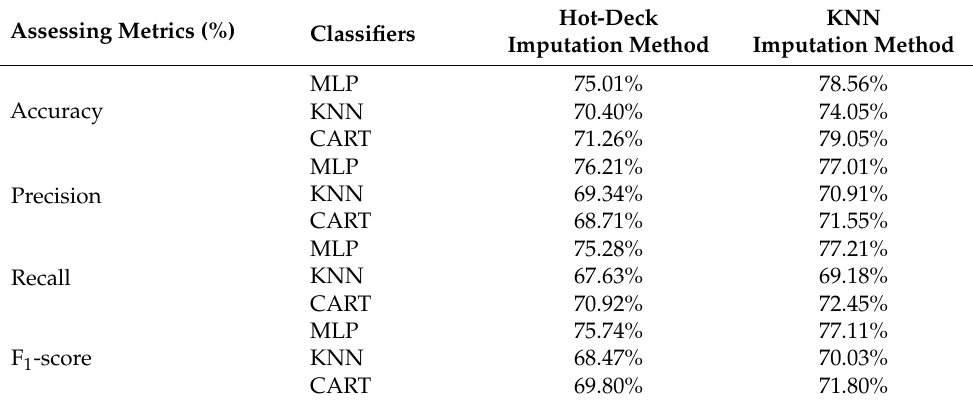
Table 2. Single imputation comparison on the MCAR dataset.